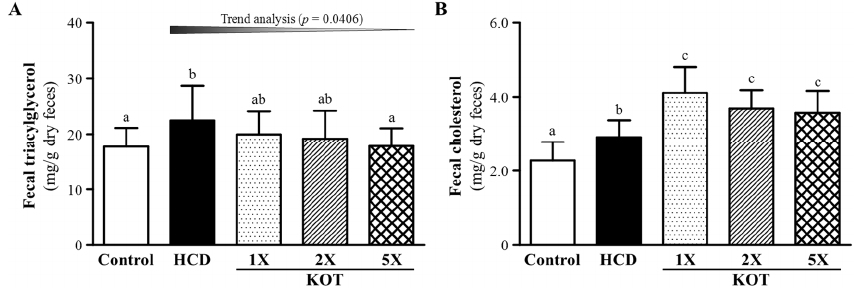
Figure 5. Effect of six-week KOT supplementation on fecal triglycerides (TG) ( A ) and total cholesterol (TC) ( B ) levels in hyperlipidemic hamsters. Data are mean ± SD, n = 8 hamsters in each group. Columns with different letters (a–c) significantly differ at p < 0.05 by a one-way ANOVA. HCD (high-cholesterol diet), HCD and the same volume of solution equivalent to BW; KOT-1X, HCD and 2787 mg/kg/day KOT; KOT-2X, HCD and 5573 mg/kg/day KOT; KOT-5X, HCD and 13,934 mg/kg/day KOT. KOT: tomato juice from Kagome